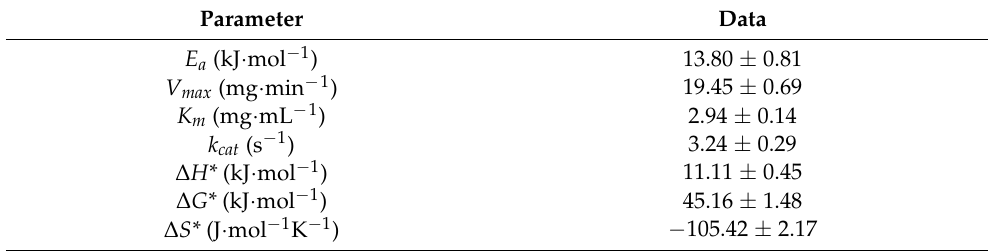
Table 2. Kinetic and thermodynamic parameters of the S. xylosus A2 protease.